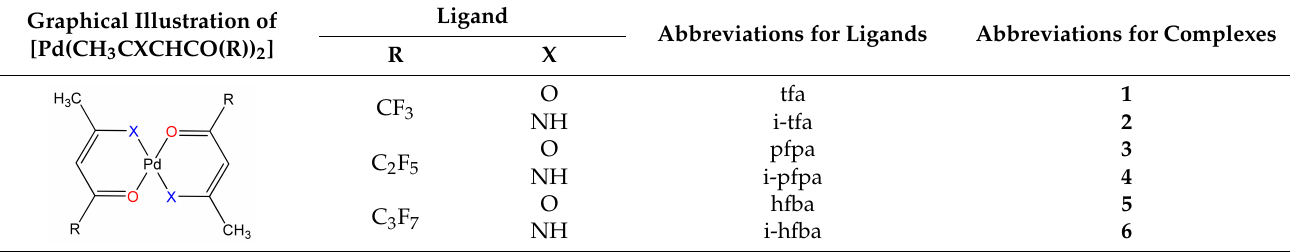
Table 1. Graphical illustration of [Pd(CH 3 CXCHCO(R)) 2 ] complexes and the abbreviations for the ligands, depending on the combination of donor atoms (X) and substituents (R). Ligand Graphical Illustration of Abbreviations for Ligands Abbreviations for Complexes [Pd(CH 3 CXCHCO(R)) 2 ]